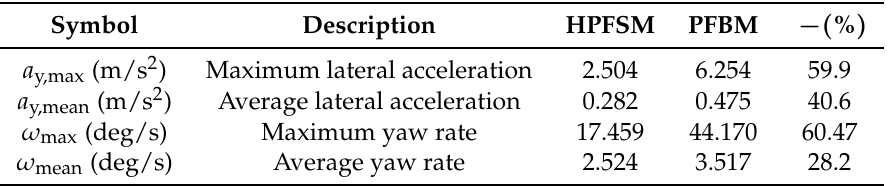
Table 4. Results comparisons in the static